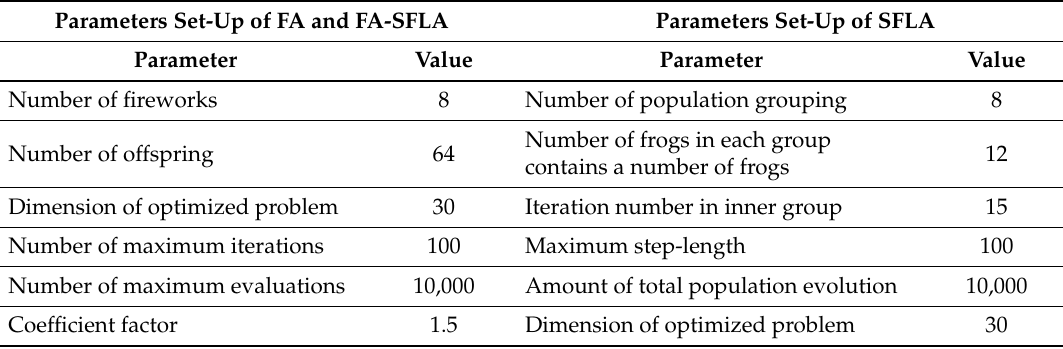
Table 2. Parameter set-up of three optimization algorithms.